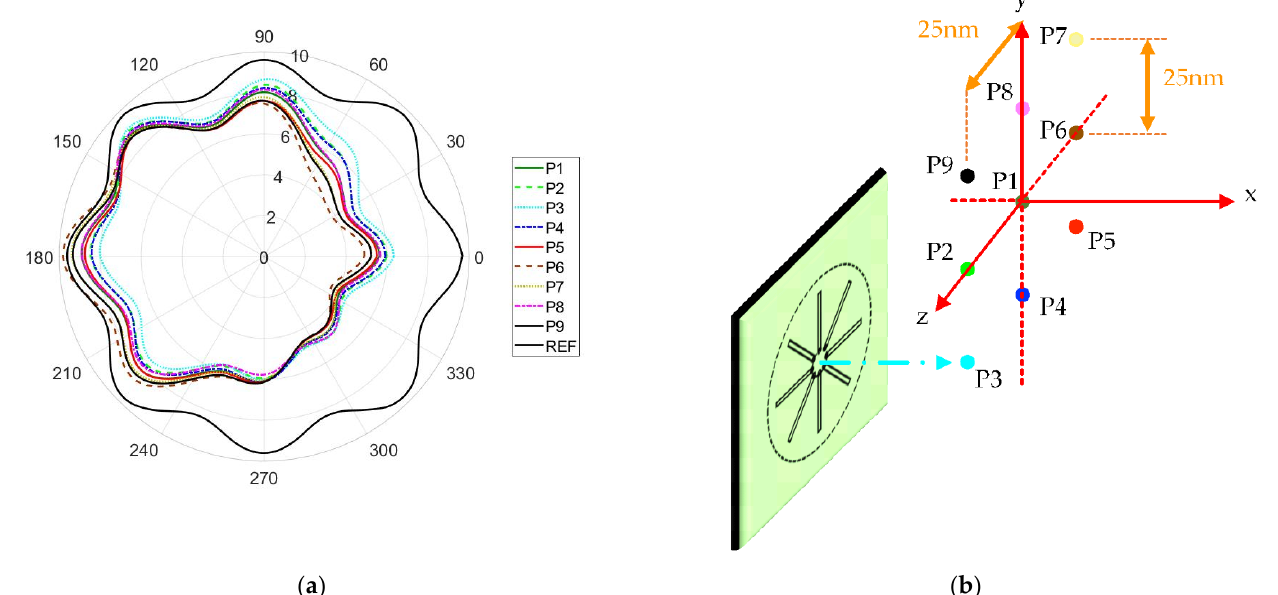
Figure 6. Contour polar plot for the gain variability at 70 nm from the center and antenna center location, simulating defocusing with step displacement adjustments. ( a ) Norm of the total electric field at ρ = 70. The black REF line is for normal incidence, and other colors are for the 45° tilted antenna with position adjustments. ( b ) The symmetrical x -axis corresponds to normal incidence; the colored position adjustments also correspond to the 45° tilted antenna. The best conditions were obtained for y = −5 nm and z = +25 nm, whereas the worst were obtained for y = +25 nm and z = −25 nm.